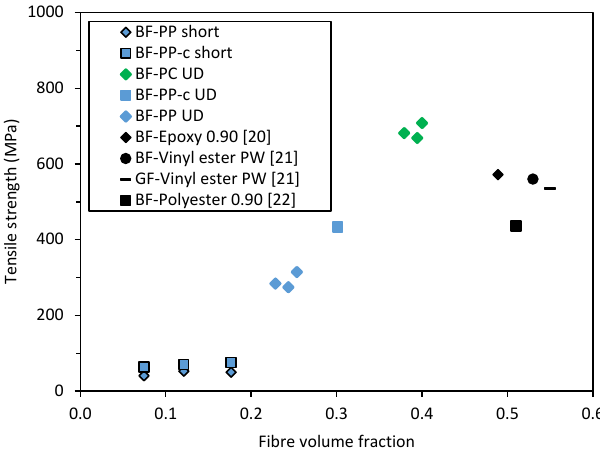
Figure 11. Benchmark of tensile strength values of BFRTP with other BFRP and GFRP. Note: Literature values are in black, and the experimental values are in green or blue. The sample nomenclature is by fibre type, matrix type and followed by the fibre architecture. For example, BF-PP short denotes the values for short BF-PP composites.